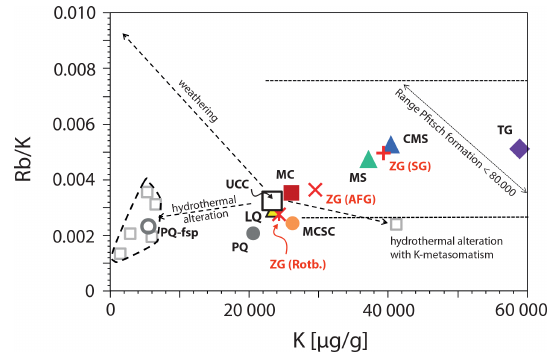
Figure 8. Rb / K vs. K as indicator of metamorphic and pre- metamorphic processes on protoliths. Plotted are average values from metasediments and basement of the Pfitsch–Mörchner basin. The large scatter of Rb / K and the variable and high K contents of the Pfitsch Formation (tourmaline gneiss, mica schist, carbonate– mica schist) are explained by being partly inherited from the source rock, dominated by Zentralgneis types, overprinted by variable in- tensity of diagenetic illite and/or K-feldspar formation (see text). The low values of Rb / K for the pyrite quartzite, especially the feldspar-bearing variety, and its MCSC lenses are consistent with the interpretation that their protoliths were hydrothermally altered rocks. Abbreviations for Zentralgneis: ZG Rot is Zillertal unit, from Rotbachlspitze; ZG AFG is Tux unit, Augenflasergneis; ZG SG is Schrammacher Gneis, Tux unit; dashed arrows indicate the influ- ence of hydrothermal alteration and weathering on protoliths (Oeser et al., 2017; UCC is upper continental crust from Rudnick and Gao, 2003). Examples for hydrothermal alteration of granitoids and granitoid-derived deposits are (grey open squares, listed from high to low Rb / K) Asarel, Bulgaria (Hikov, 2013); Horn Mine, Virginia, USA (Owens and Paseck, 2007); Loma Blanca, Argentina (Marfil et al., 2010); Oyu Tolgoi, Mongolia (Kashgerel et al., 2001); and Sanshandao, China (Li et al., 2013), which is given as an example of enrichment of K during hydrothermal alteration of